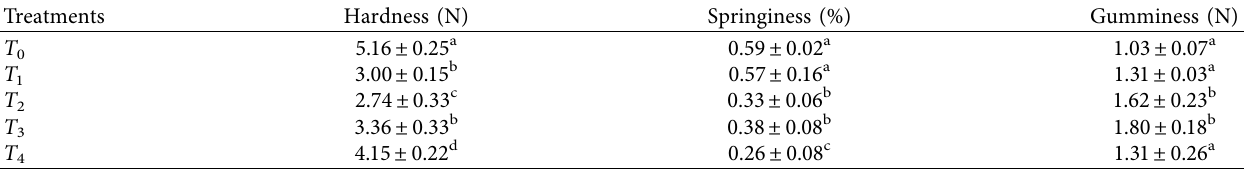
Table 7: Textural attributes moringa leaf powder (MLP)-supplemented whole wheat four leavened bread. Treatments